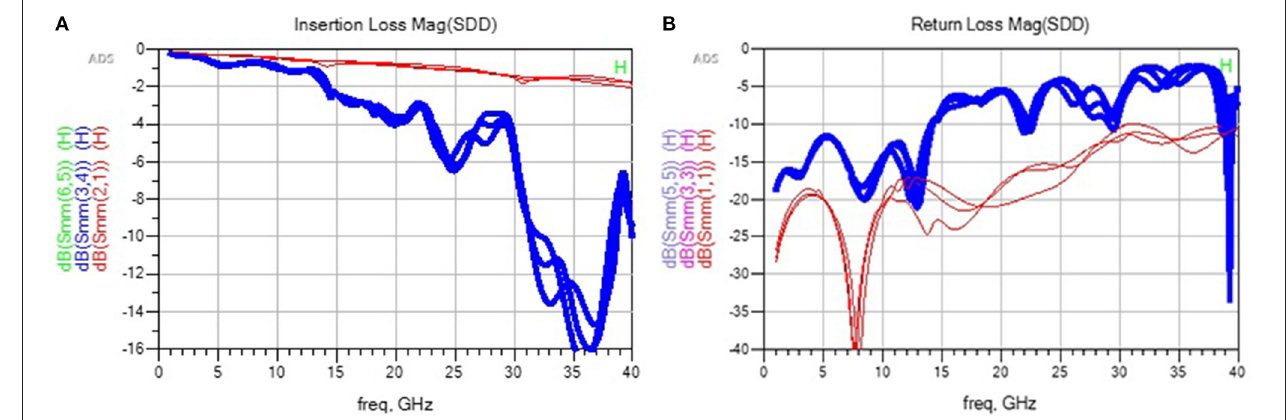
FIGURE 4 | Package EM model results. (A) S-parameter simulations for insertion loss and (B) return loss for the RF signal path with (blue) and without (red) the module external connector.